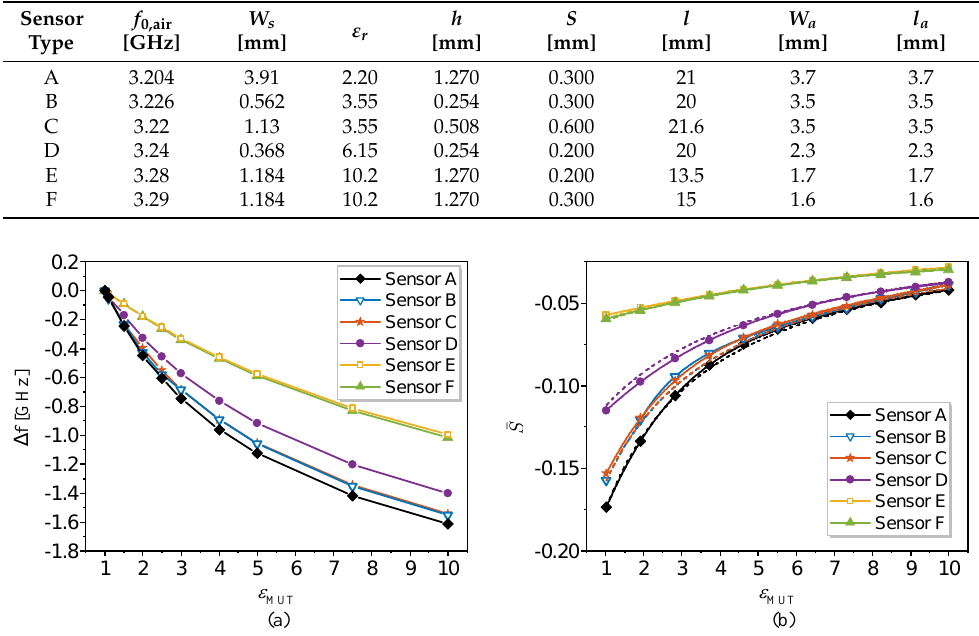
Figure 3. Variation of the resonance frequency with the dielectric constant of the MUT ( a ) and relative sensitivity ( b ) for sensors A, B, C, D, E and F. The theoretical relative sensitivity inferred from expression (10) is also included in ( b ), in dashed line. Reproduced with permission from